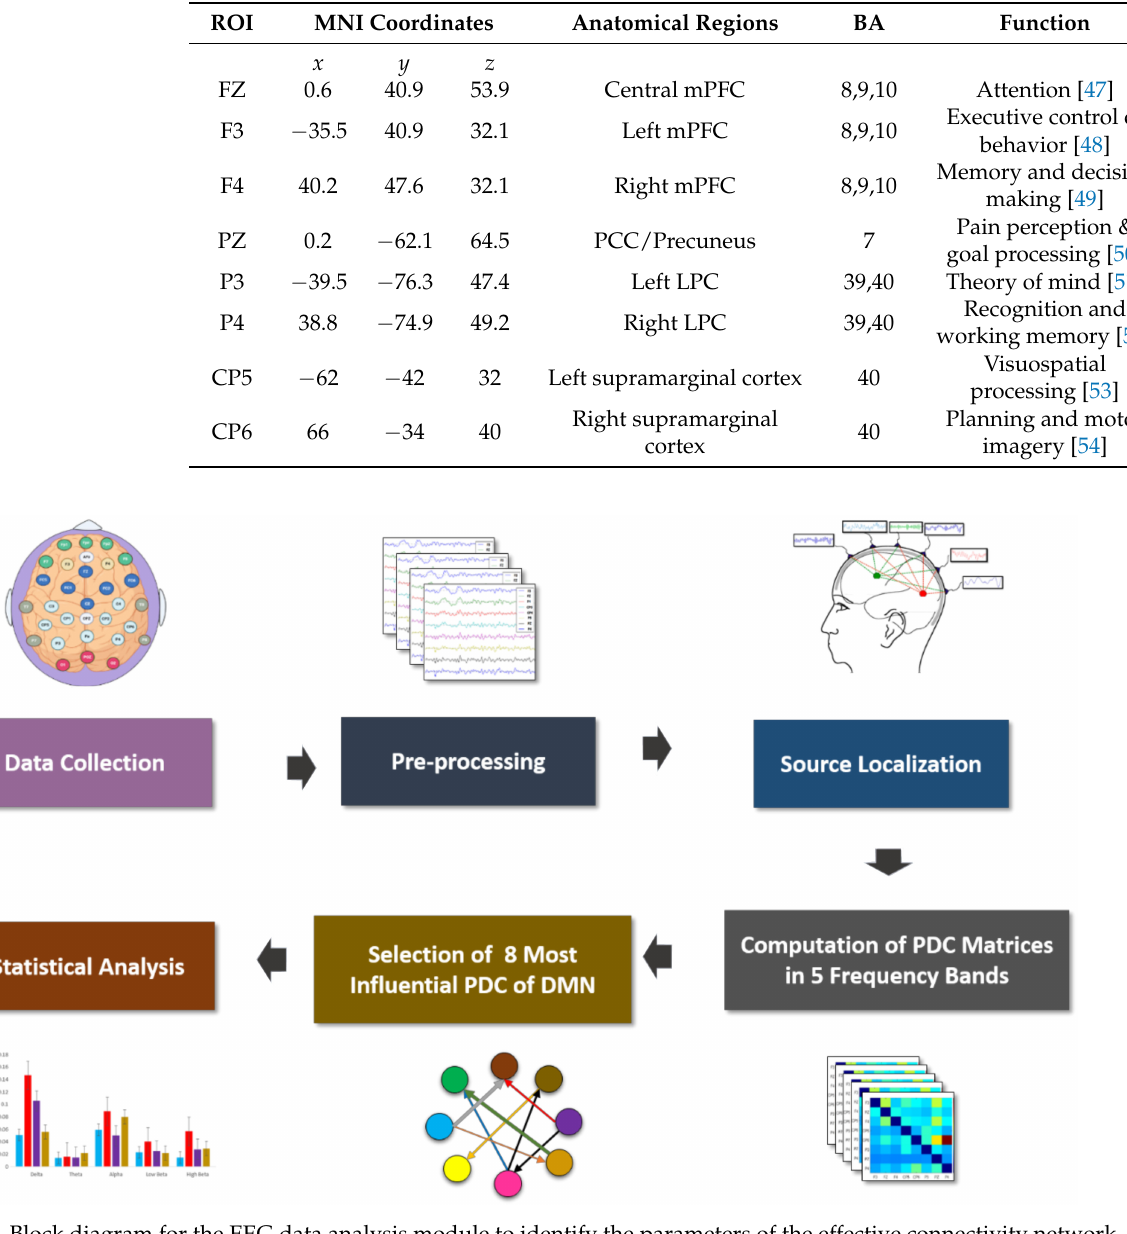
Figure 2. Block diagram for the EEG data analysis module to identify the parameters of the effective connectivity network between default mode network (DMN)